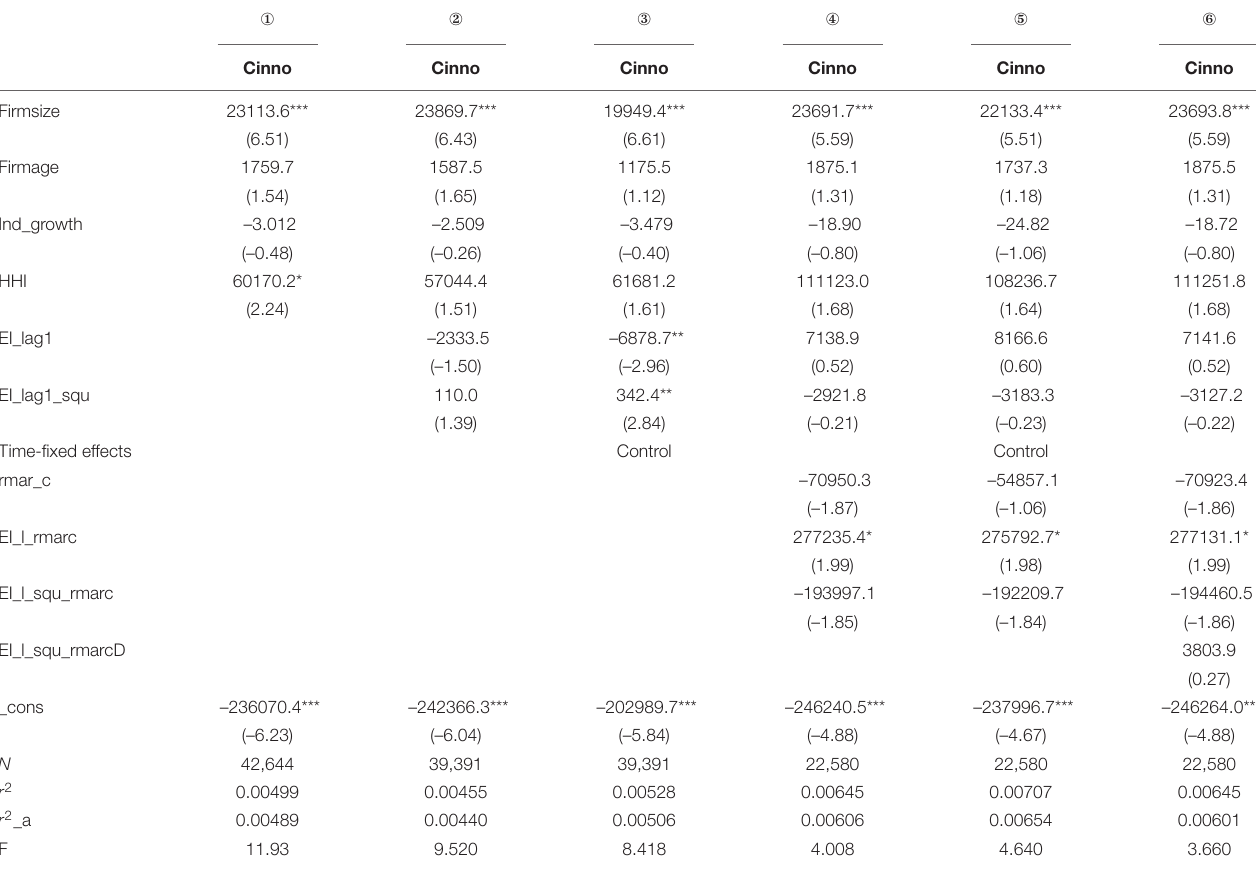
TABLE 3 | Results of the analysis of the relationship between exports and innovation and the moderating role of institutional development.